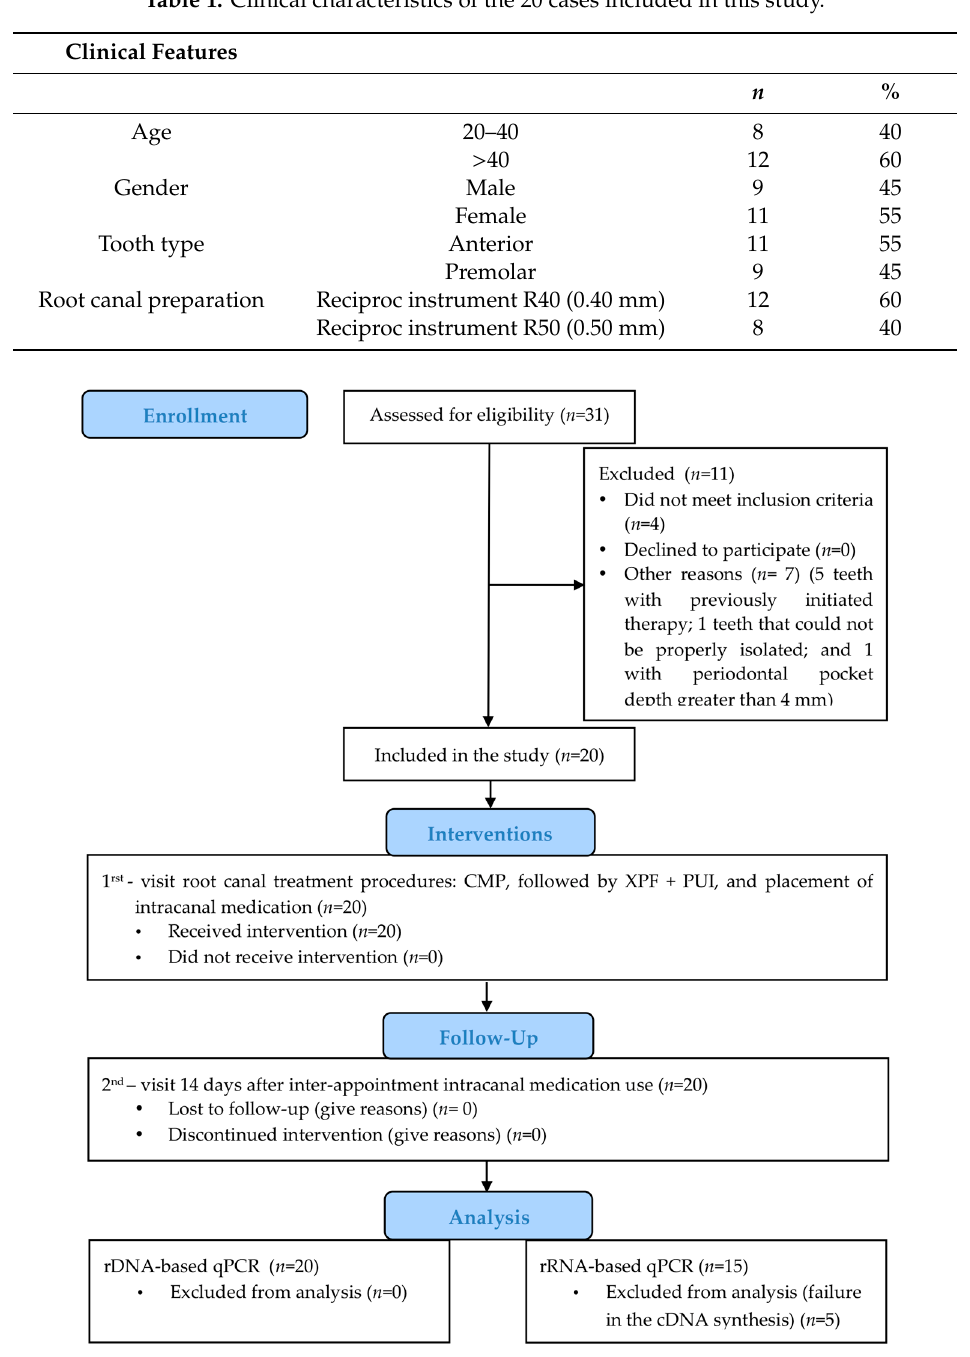
Figure 2. Flow diagram of the clinical trial. CMP, chemo-mechanical preparation; XPF, XP-endo Finisher; PUI, Passive ultrasonic irrigation; qPCR, quantitative polymerase chain reaction; rDNA, rRNA gene; rRNA, ribosomal rRNA.